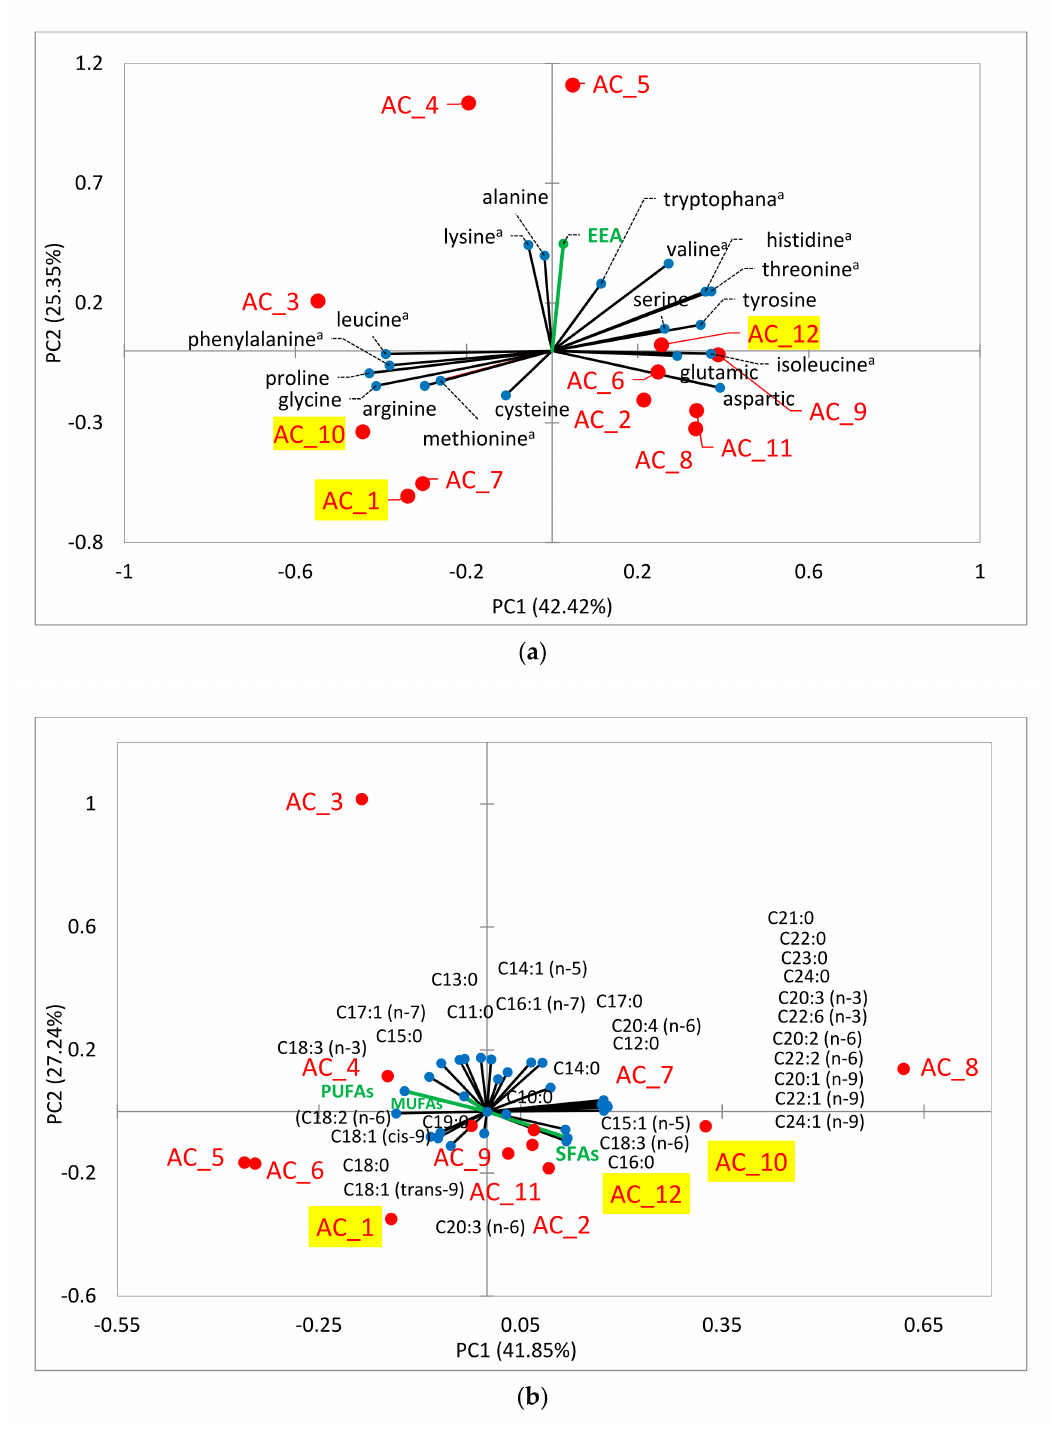
Figure 2. ( a ) Principal component plots for microalgae-microbial consortia (AC) vs. amino acids and ( b ) vs. fatty